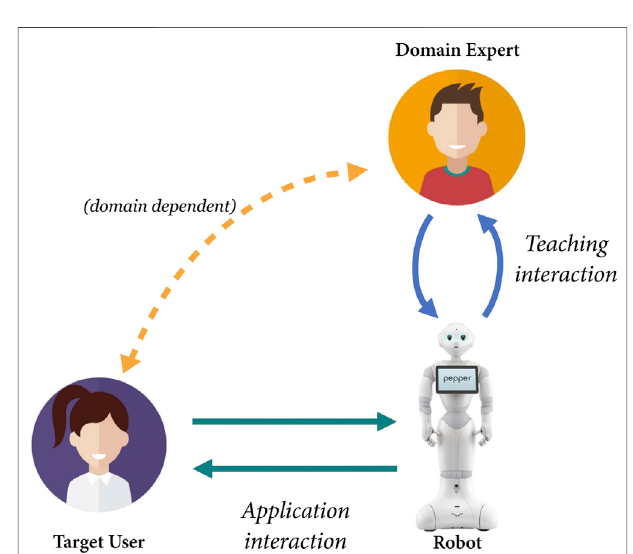
FIGURE 2 | Three-way interaction between the domain expert, the robot,andthetargetuserthroughwhichtheexpertteachestherobotduringa teaching phase upon real-world deployment. Robot automation is therefore happening in the real world, whereas the robot is fully embedded in its long-term application context. The expert is teaching the robot through bi- directional communication, as the robot interacts with the target user. The extent of interaction(s) between the domain expert and target user should be consistent with what is envisaged for long-term deployment of the robot and is domain-dependent. People vector created by studiogstock -